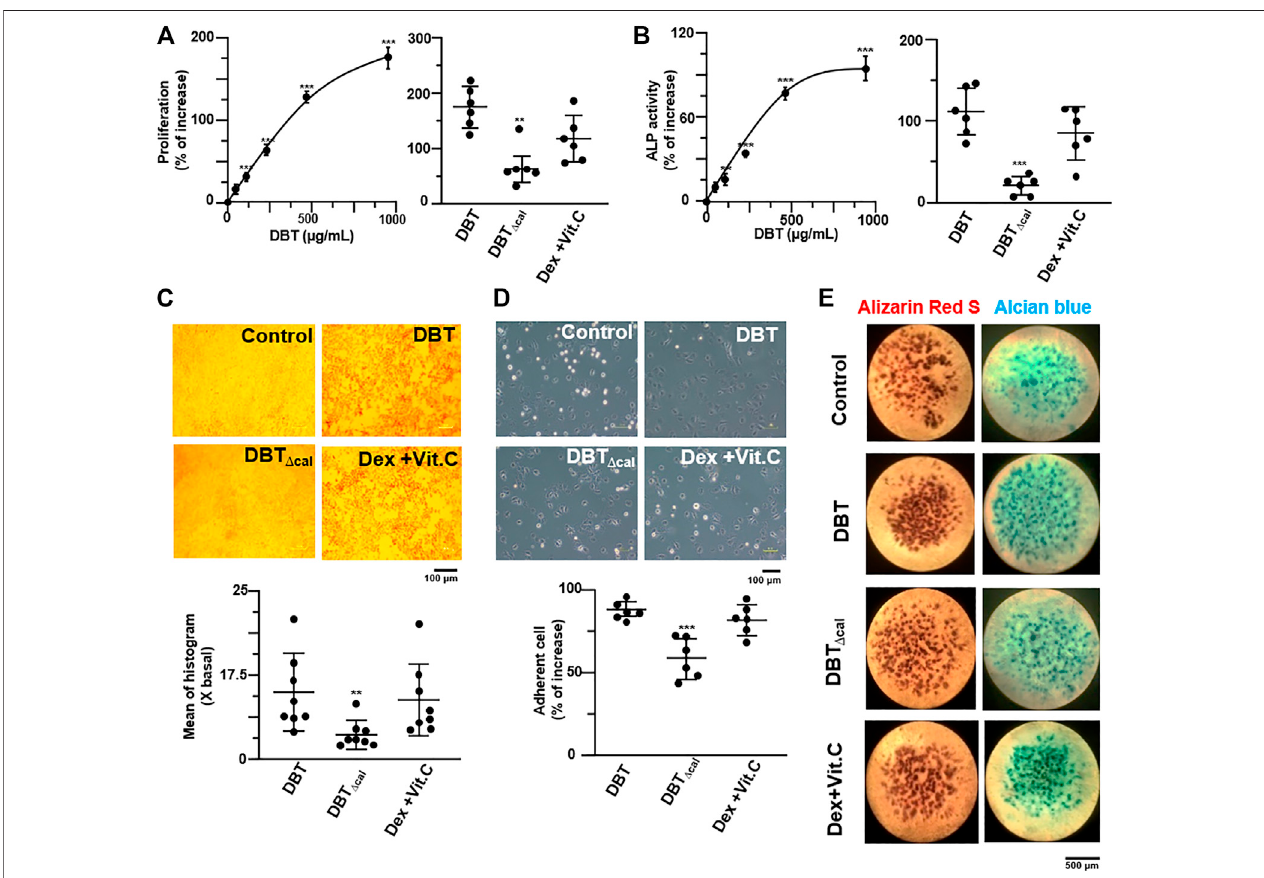
FIGURE 1 | DBT and DBT Δ cal in osteoblastic differentiation. (A) : DBT at different concentrations was applied onto cultured osteoblast for 7 days to analyze cell proliferation, triggered by the herbal extract. The proliferation was compared between DBT and DBT Δ cal (both at 1 mg/ml). (B): ALP activity was assayed in different treatments, as in (A) . (C): The osteoblasts were treated with DBT and DBT Δ cal as in (A) , before staining with Sirius Red. Micrographs were taken by phase-contrast microscopy (upper panel). One representative result is shown. The quanti fi cation of colorimetric intensity was calculated by the image J (lower panel). (D) : The treatments of osteoblasts were the same as in (A) . The cell adhesion ability was measured (upper panel). The quanti fi cation was calculated by the image J (lower panel). (E) :MicromassculturesofmouselimbbudcellswereincubatedinDBTandDBT Δ cal (bothat1 mg/ml)for7 days.Thecartilageformedinaninnertissuecore,followedby a ring of mineralization near the periphery, as shown by Alcian blue and Alizarin Red S. Vitamin C (250 μ M) and dexamethasone (20 nM) served as a positive control (Yu et al., 2020). Values were expressed as % of increase, or fold of change (X basal), of the control in Mean ± SEM, where n (cid:2) 6. * p < 0.05, ** p < 0.01, *** p <